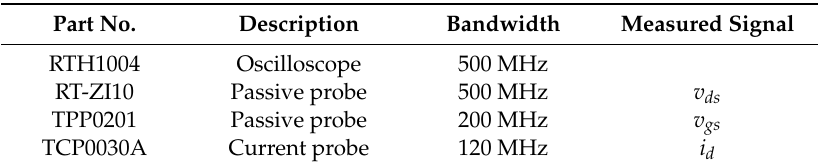
Table 4. Specification of the measurement